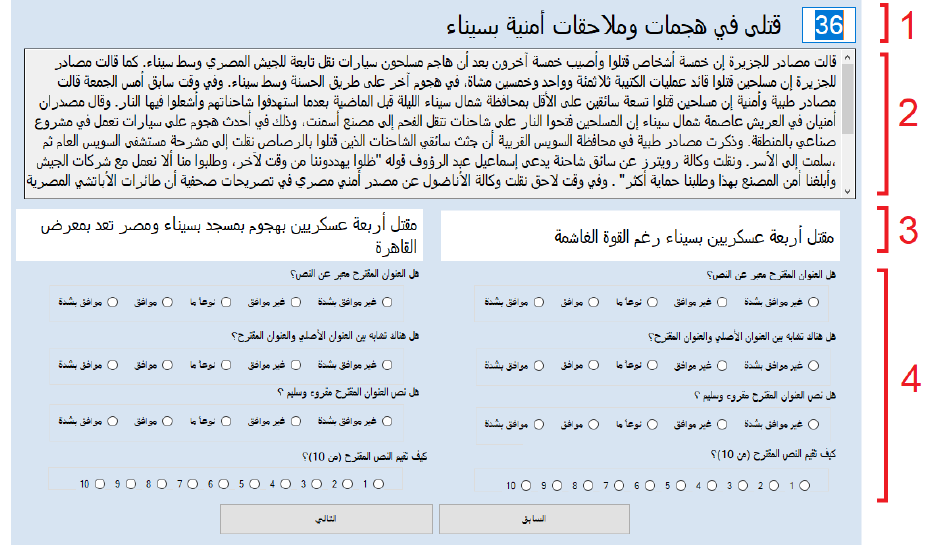
Figure 6. Screenshot of manual assessment